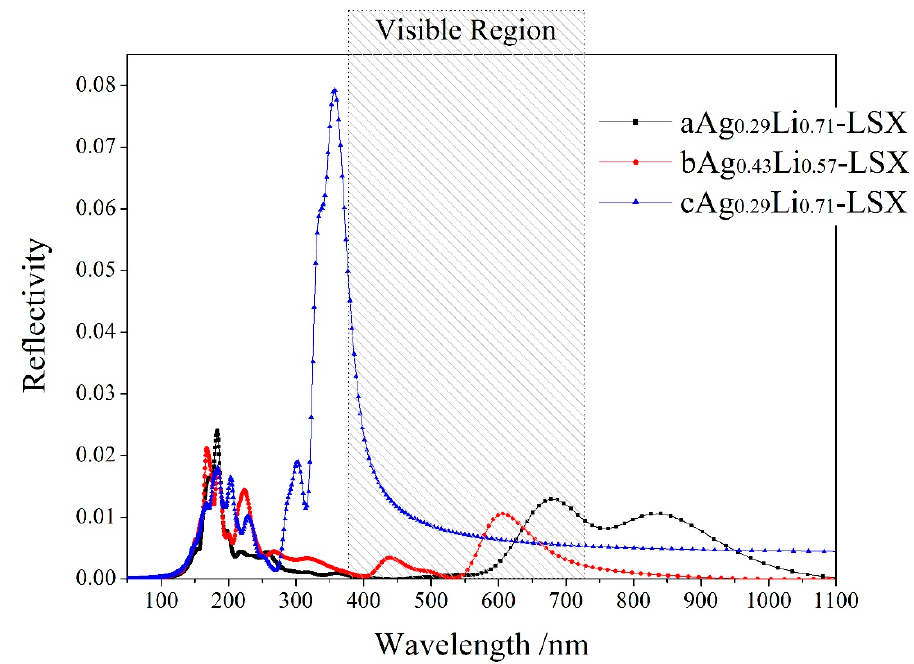
Figure 7. The calculated optical reflectivity spectra of Ag-exchange Li-LSX with the unpolarized light being incident along [001] crystallographic direction.